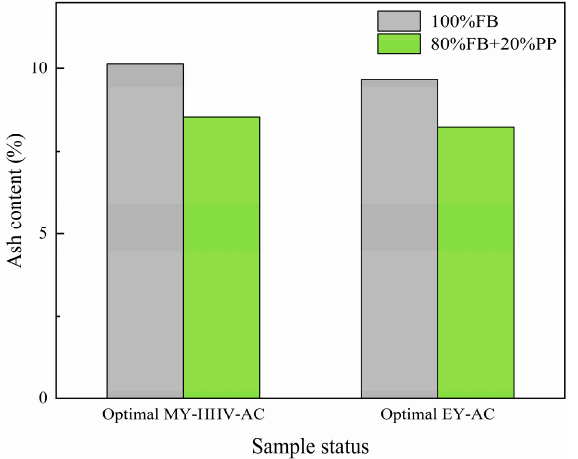
Figure 7. Ash content of 100% FB and mixed 20% PP under two sets of optimized conditions.